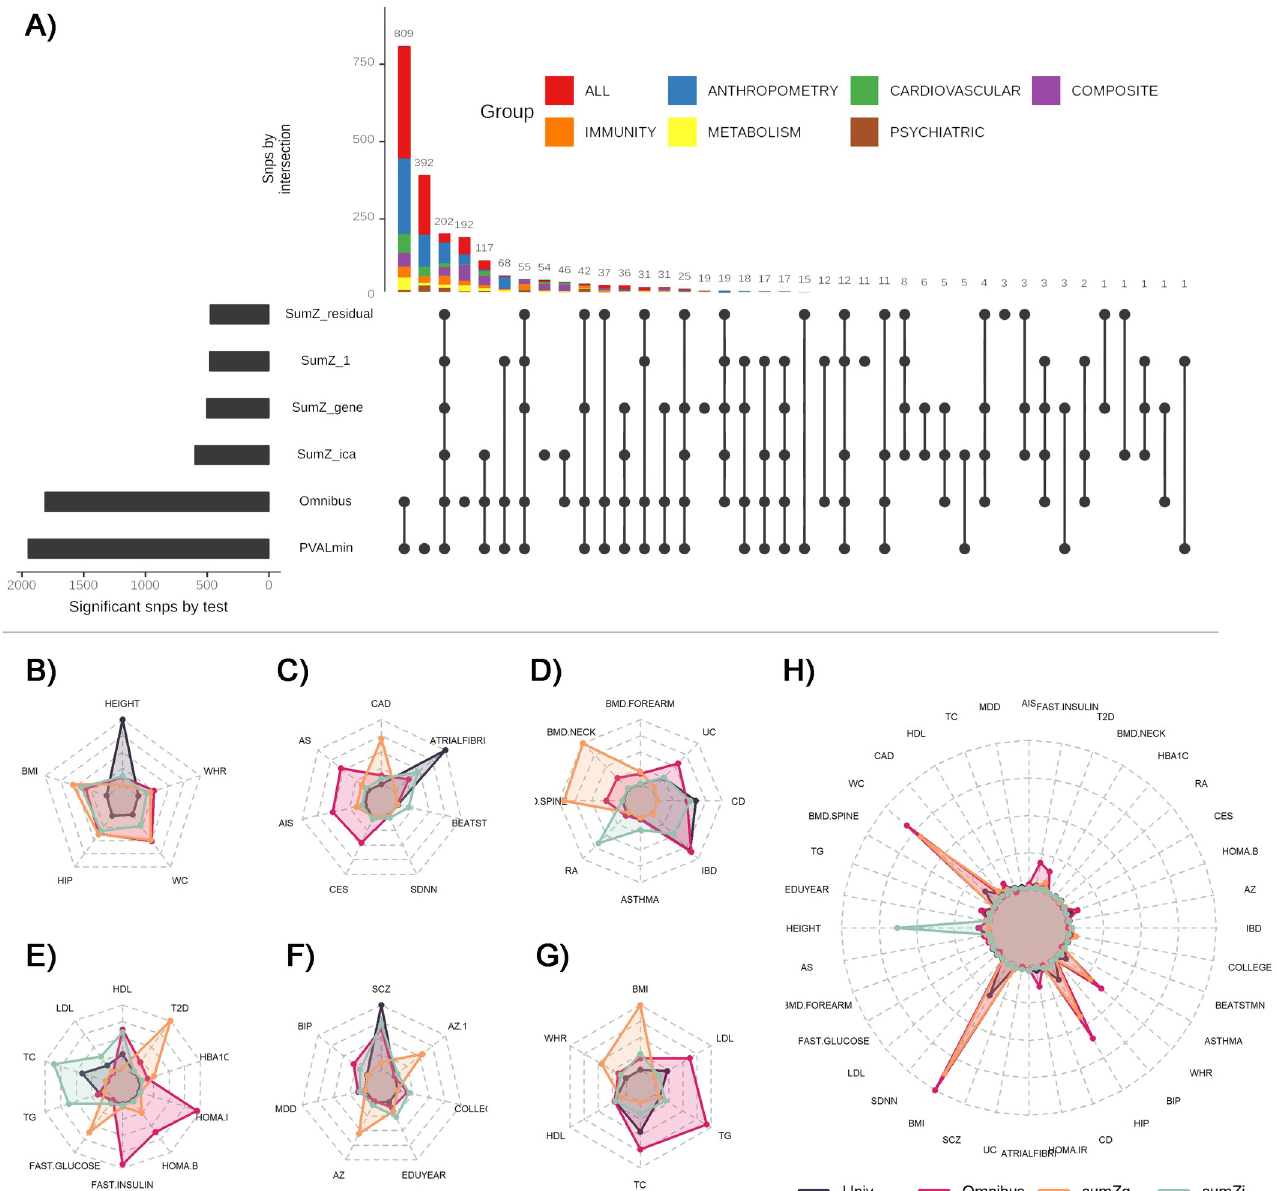
Fig 3. Multitrait approach comparison. Panel ( A ) shows independent variants detected across the six approaches: univariate test ( univ ), omnibus test ( omni ), weighted sum of Z-score with uniform weight ( sumZ 1 ), weight defined as the loading of the first principal component of the phenotypic correlation ( sumZ r ), the ), or defined using the loadings of an independent component analysis ( sumZ ). Each line corresponds to a test and each column to a genetic correlation ( sumZ g i ca set of significant variants. For each set, the test for which variants are significant are represented with a black dot on the test line. The barplot at the left represents the total number of significant independent signals detected by each approach. The stack bar at the top represents the cardinality of the sets. The next panels show the link between strengths of univariate association signal and the relative performance (i.e. larger power) of the four most tests: univ , omni , sumZ , and g sumZ i ca , for each phenotype set: anthropometry ( B ), cardiovascular ( C ), immunity ( D ), metabolism ( E ), brain ( F ), composite ( G ), and all phenotypes ( H ). Within each phenotype set, we split the top associated SNPs per region based on the most significant test, and derived the median chi-squared for each test. The radar plots show the derived median per test and illustrate the strong heterogeneity in patterns identified. For example, out of the 1605 SNPs from the anthropometry set, 1235 had stronger signal with univ as compared with other tests. The median chi-squares in that group were 49.1, 1.1, 2.0, 1.0, and 0.7 for height, body mass index (BMI), hip circumference (Hip), waist circumference (WC), and waist to hip ratio (WHR). Comparatively, the 267 SNPs harboring a stronger signal with omnibus , had median of 6.8, 20.1, 15.9, 11.2, and 7.2 for the same phenotypes.